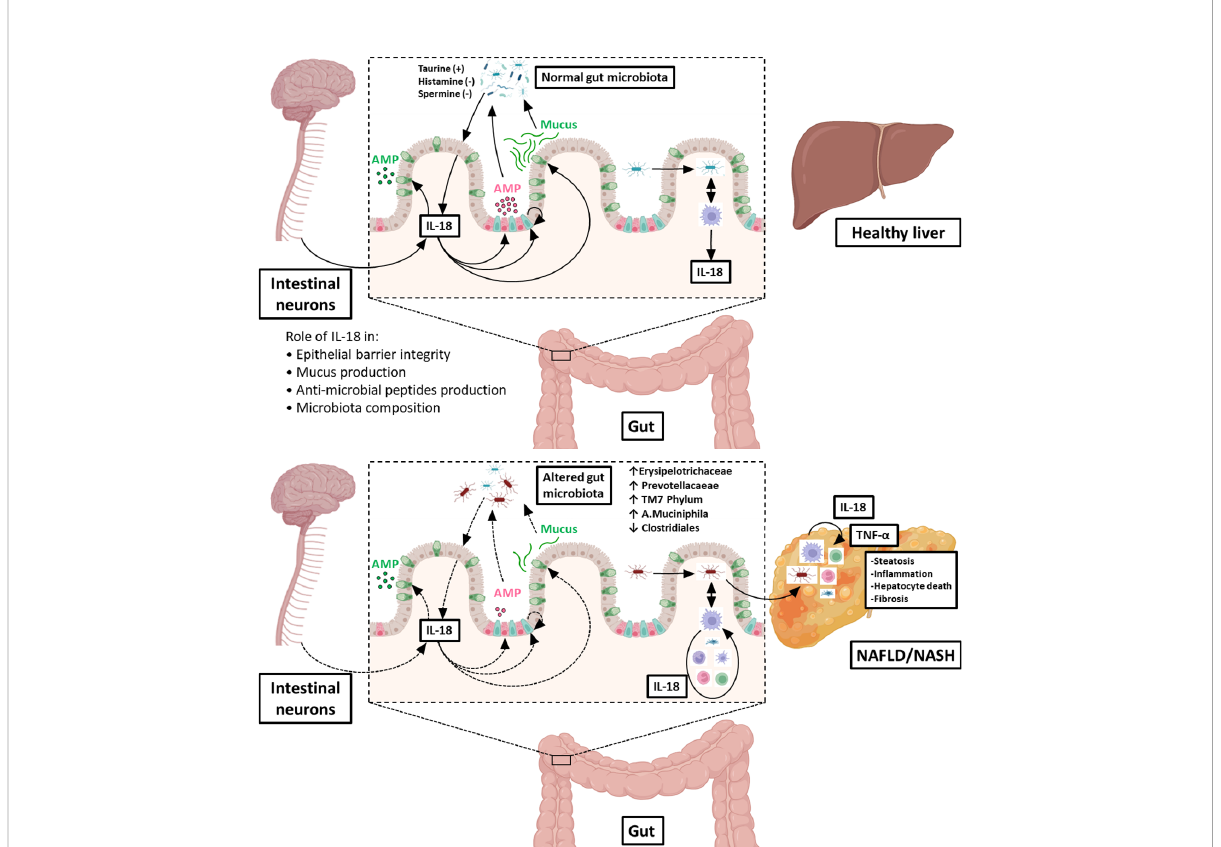
FIGURE 2 Role of IL ‐ 18 in the gut microbiota balance and consequences on the gut-liver axis. Under physiological conditions (upper illustration), IL ‐ 18 is produced by intestinal epithelial cells (in light pink) and is regulated by microbiota-derived metabolites (such as taurine, histamine or spermine). IL ‐ 18 maintains intestinal barrier integrity through stimulation of production of anti ‐ microbial peptides (AMP) by Paneth cells (in dark pink), mucus synthesis by goblet cells (in green) and epithelial proliferation through induction of epithelial stem cells (in blue). In addition, IL-18 is also produced by intestinal neurons controlling homeostatic goblet cells AMP production. In this way, IL ‐ 18 contribute to maintain a normal microbiota in the digestive tract. When commensal bacteria enter the mucosa, macrophages from the lamina propria secrete IL ‐ 18, which participate to control infection. In pathological conditions (lower illustration), the intestinal epithelial barrier is disrupted, and microbes can enter in the lamina propria where they stimulate resident macrophages to produce IL ‐ 18. This excess of IL-18 is deleterious to intestinal